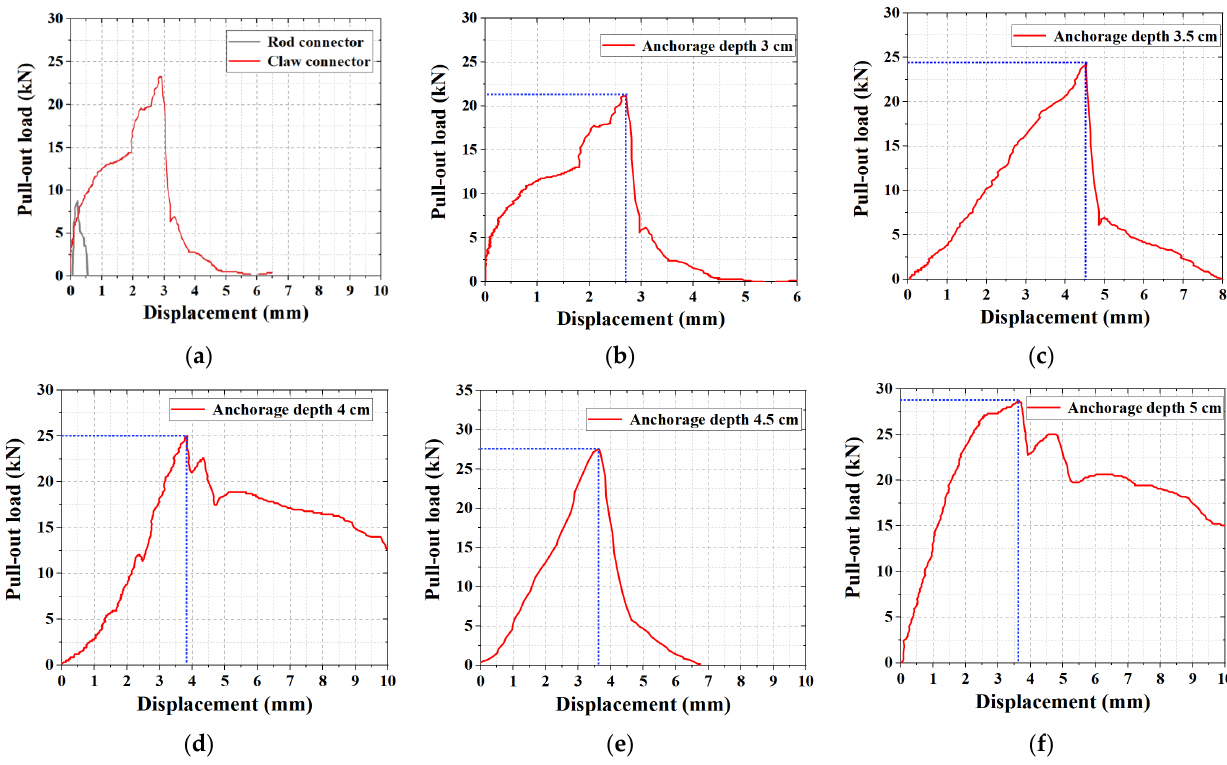
Figure 8. Load–displacement curves of the pull-out test: ( a ) Comparison of the rod and claw connectors. Tensile strengths of the rod and claw connectors at ( b ) 3 cm anchorage depth; ( c ) 3.5 cm anchorage depth; ( d ) 4 cm anchorage depth; ( e ) 4.5 cm anchorage depth; ( f ) 5 cm anchorage depth.